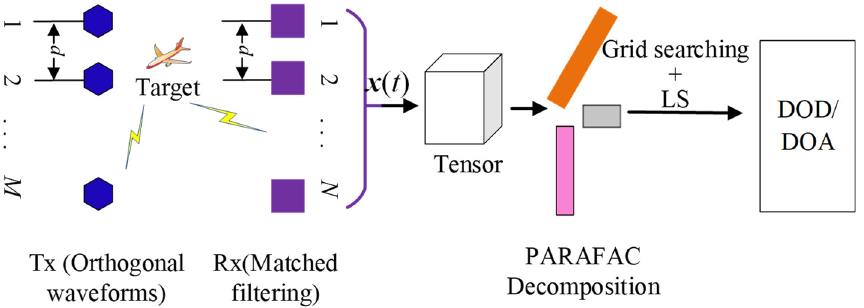
Figure 1. Illustration of the proposed estimator.